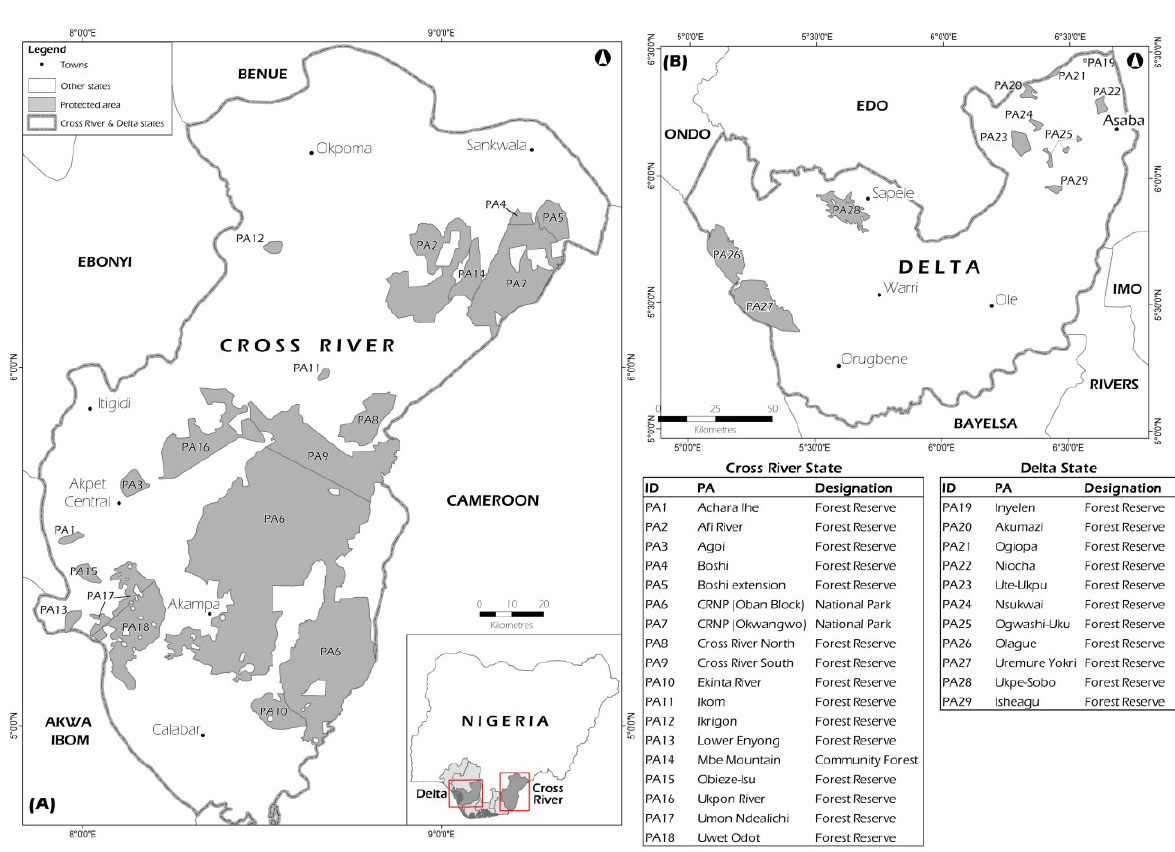
Figure 1. Map of study area showing distribution of protected areas in ( A ) Cross River and ( B ) Delta states, located in the Niger delta region of